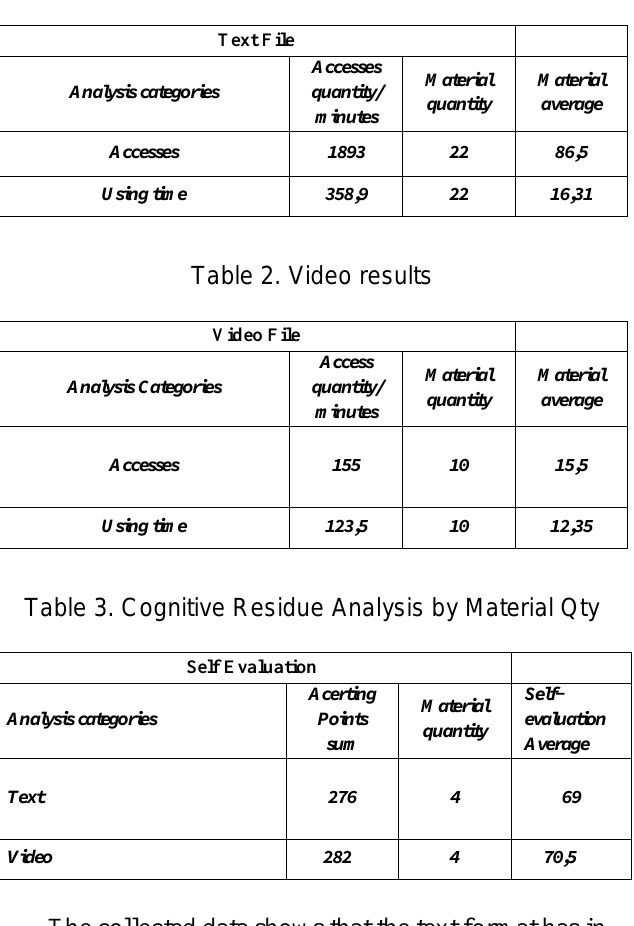
Table 1. Text files reading results